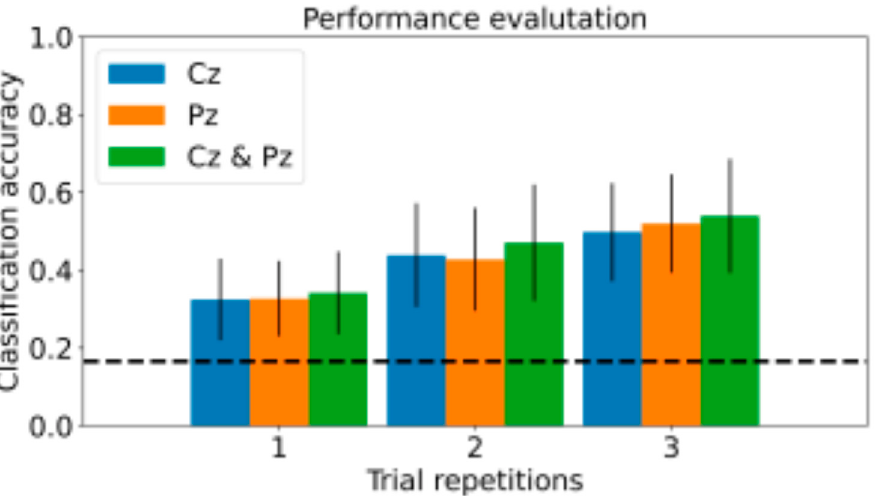
Figure 8. Average subject-specific classification accuracy varying EEG channels configuration and the number of repetitions of the menu icons.